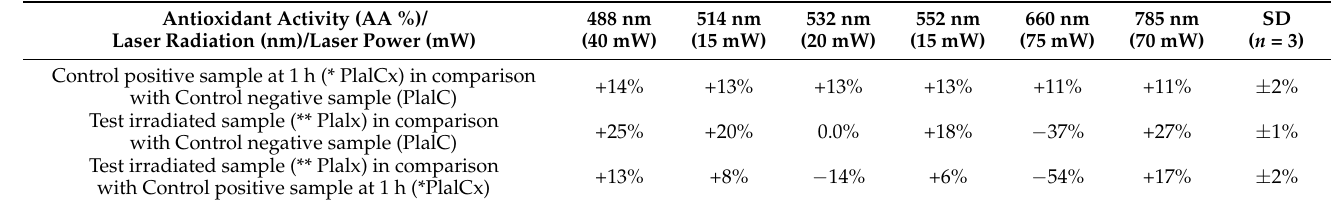
Figure 5. ( a – f ) Antioxidant activity of the test irradiated extracts vs. control extracts at 1 h and 2 h extraction time, in comparison with control negative sample: ( a ) Series at 488 nm; ( b ) Series at 514 nm; ( c ) Series at 532 nm; ( d ). Series at 552 nm; ( e ) Series at 660 nm; ( f ) Series at 785 nm (mean values, n = 3).